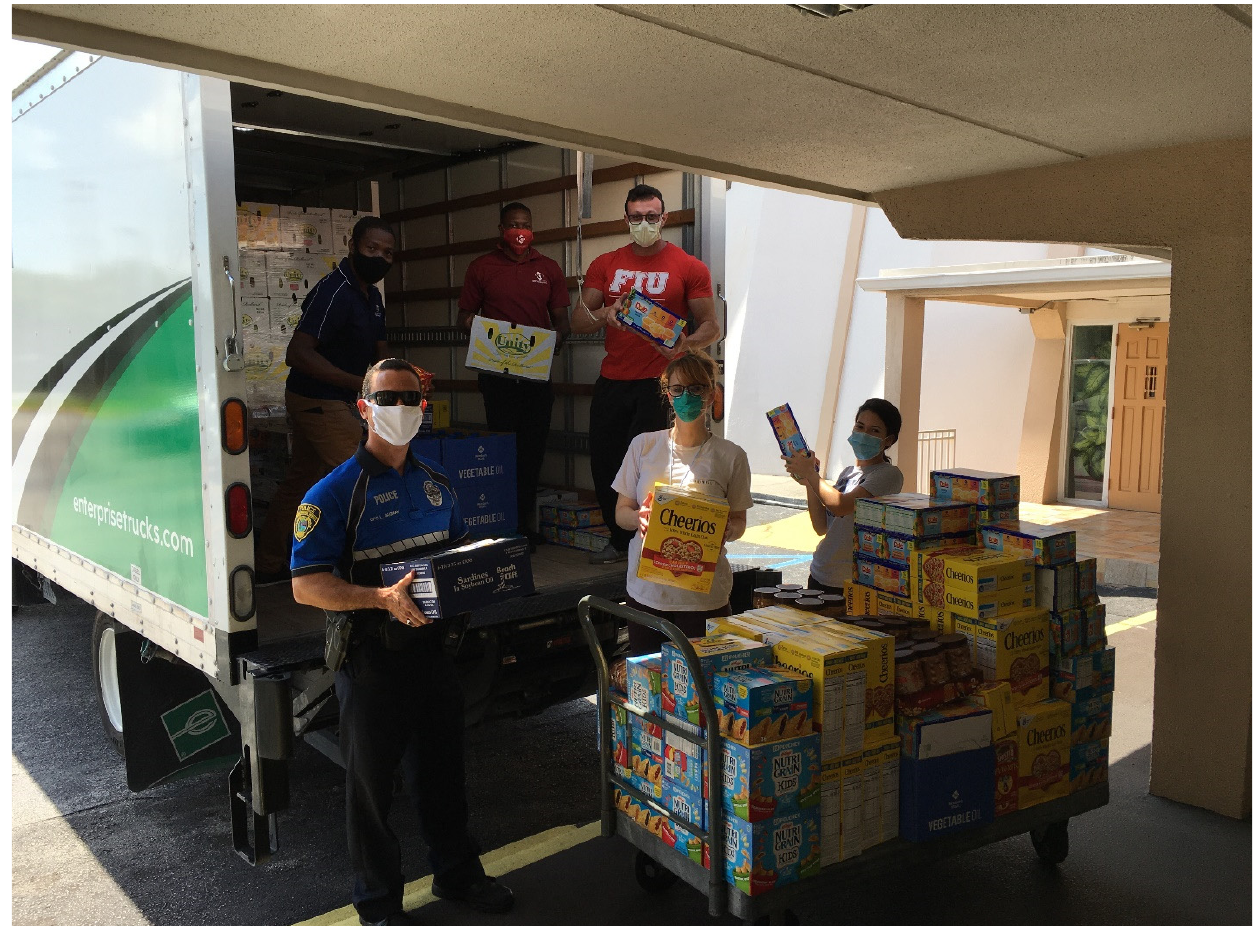
Figure 3. Team Heading to the Food Distribution Site.